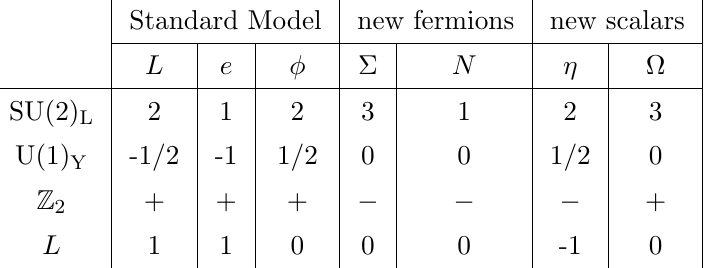
Table 1 . Fields of the STSM and their quantum